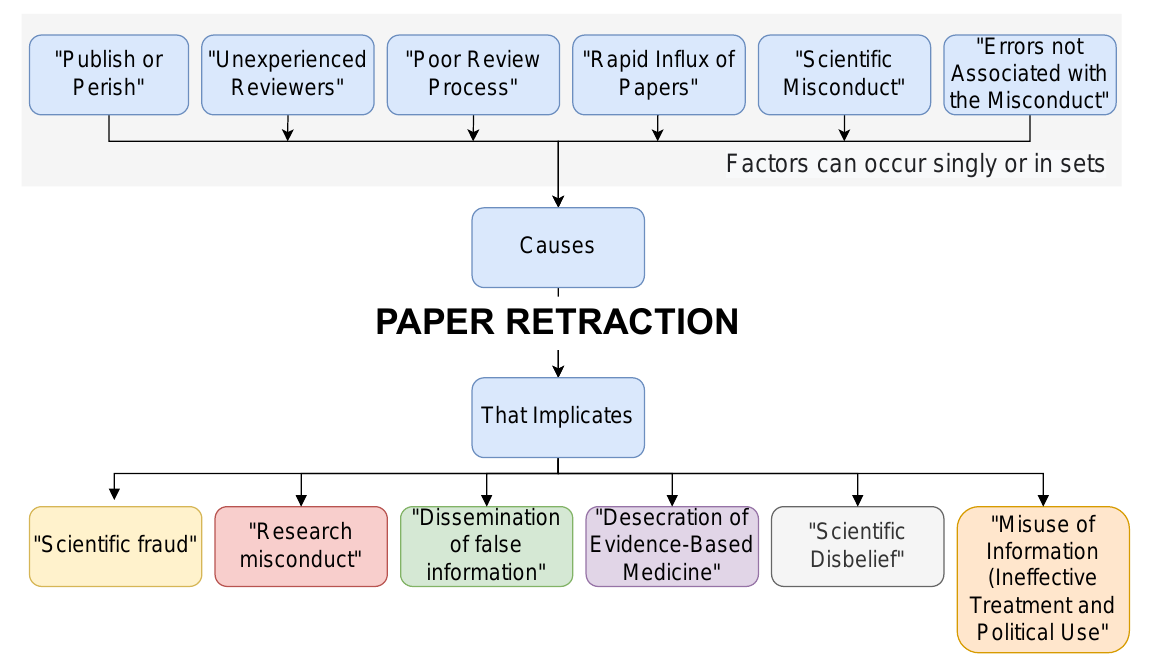
Figure 3. Paper retraction (causes and implications).